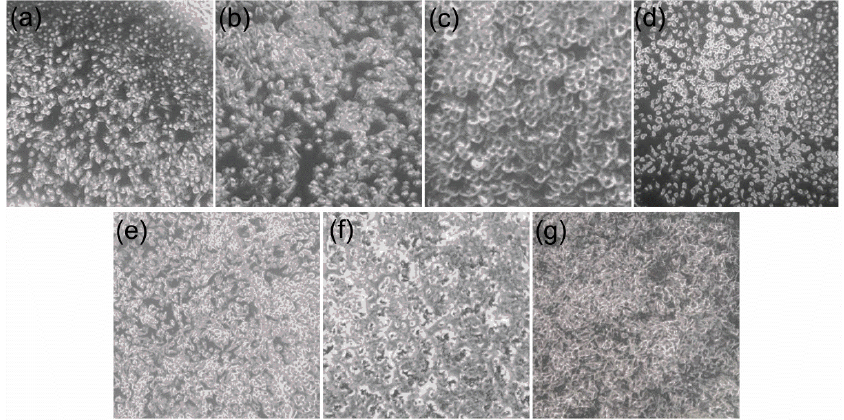
Figure 10. Optical images of cellular confluence after treatment of increasing doses of cyanine dye 8a : ( a ) negative control, ( b ) 0.005 μ M, ( c ) 0.01 μ M, ( d ) 0.05 μ M, ( e ) 0.1 μ M, ( f ) 0.5 μ M, and ( g ) 5.0 μ M after 30 min of incubation.